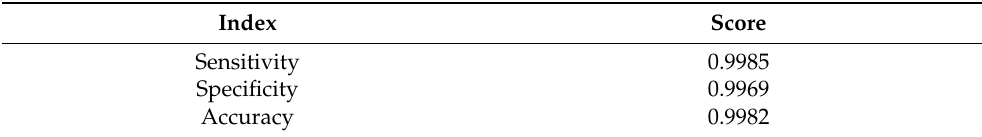
Table 4. Classification performance of normal and MI classes in Setting 1.